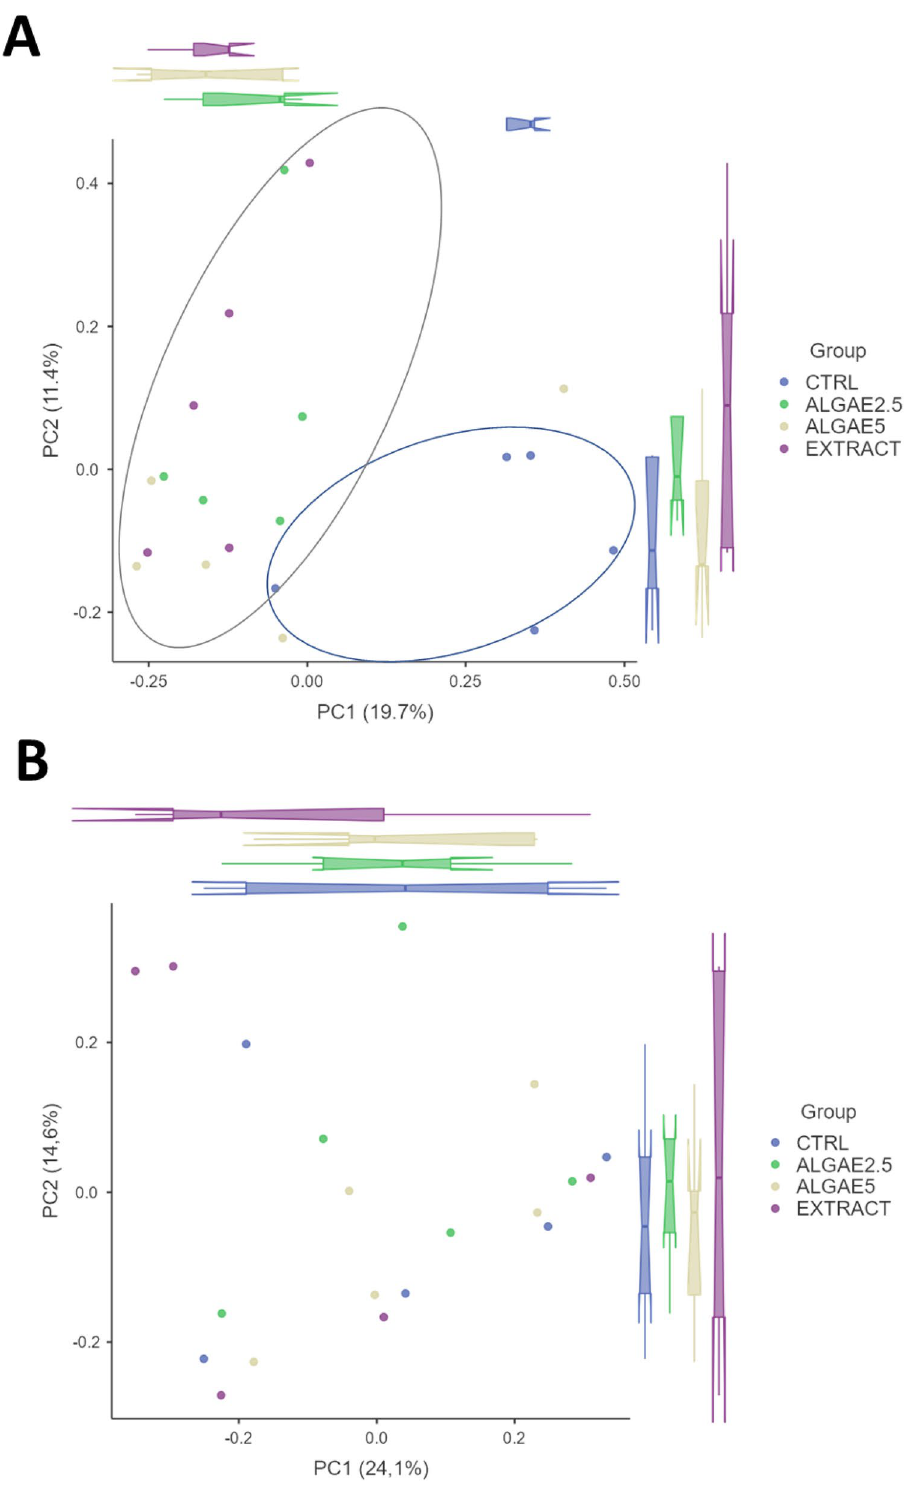
Figure 2. Principal coordinate analysis (PCoA) of Bray–Curtis dissimilarities observed in seabass anterior ( A ) and posterior intestine ( B ) microbial communities. Box plots represent the average coordinate for each group in the correspondent axis (i.e., PC1 or PC2). Ellipses indicate a significant separation between CTRL group (right ellipse) and other groups (left ellipse) based on PERMANOVA (P = 0.003). Fish were fed a basal diet with no supplement (CTRL) or supplemented with Gracilaria gracilis powdered biomass at 2.5% (ALGAE2.5), at 5% (ALGAE5) or with the seaweed extract at 0.35% inclusion rate